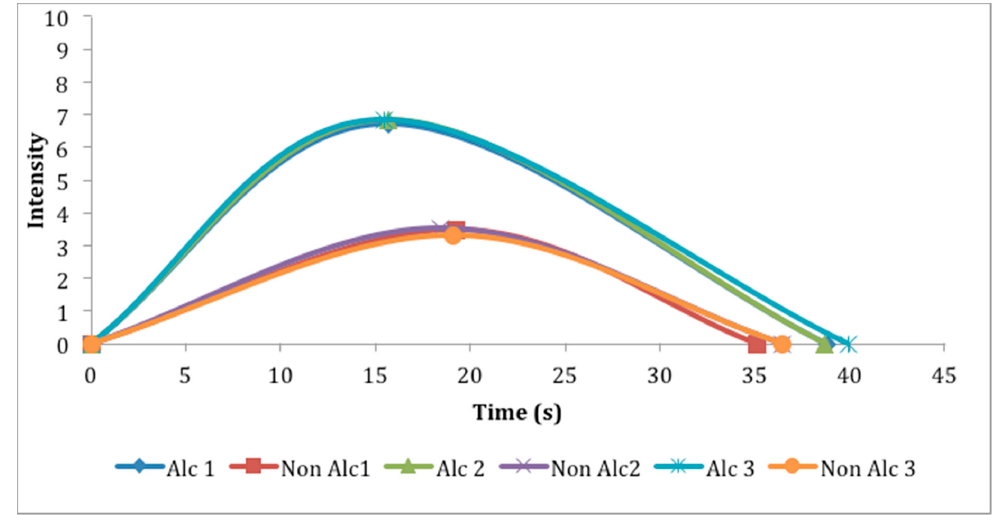
Figure 3. Time-intensity curves related to the bitter stimulus of Pilsen-type beers of alchool and non-alcoholic beers. Abreviations = Alcoholic Sample 1 (Alc1); Alcoholic Sample 2 (Alc2); Alcoholic Sample 3 (Alc3); Non-Alcoholic Sample 1 (Non Alc 1); Non-Alcoholic Sample 2 (Non Alc 2); Non-Alcoholic Sample 3 (Non Alc